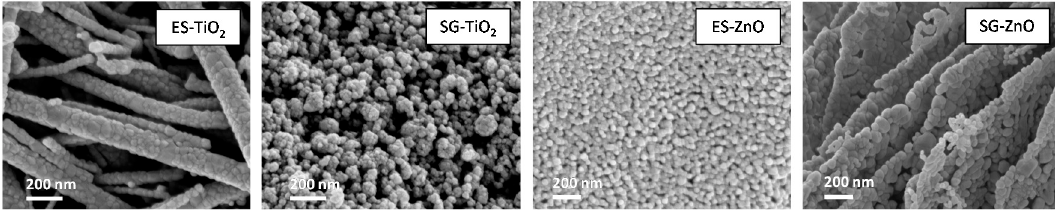
Figure 2. SEM micrographs of the ES and SG-TiO 2 films fired at 650 °C and of ES- and SG-ZnO powders calcined at 450 °C.